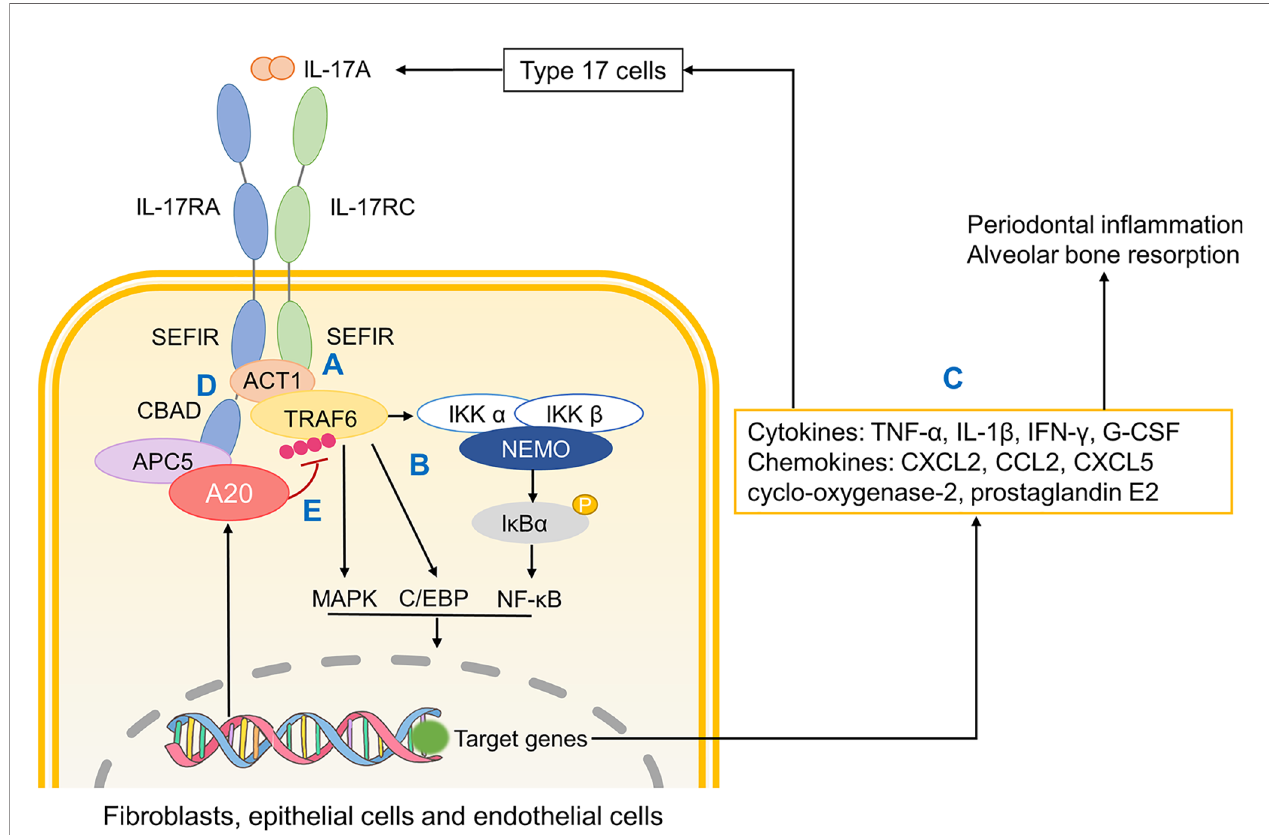
FIGURE 4 | The role of A20 in IL-17A signaling. (A) Upon IL-17A activation, two SEFIR domains respectively in IL-17RA and IL-17RC bind to Act1. Then Act1 recruits and ubiquinates TRAF6. (B) Ubiquinated TRAF6 activates downstream MAPK, C/EBP and NF- k B pathways. (C) Related gene transcription promotes the production of cytokines, chemokines that not only promote in fl ammatory responses and osteoclastic resorption but also further recruit monocytes and macrophages. (D) CBAD in IL-17RA helps TRAF3 replace Act1, which terminates IL-17R signaling. (E) A20 binds to the inhibitory domain CBAD through APC5 thus ceasing downstream pathways. SEFIR, SEF/IL-17R; TRAF, tumour necrosis factor receptor-associated factor; MAPK, mitogen-activated protein kinase; NF- k B, nuclear factor- k B; CBAD, CCAAT/enhancer binding protein b (C/EBP b ) activation domain; APC5, anaphase promoting complex protein